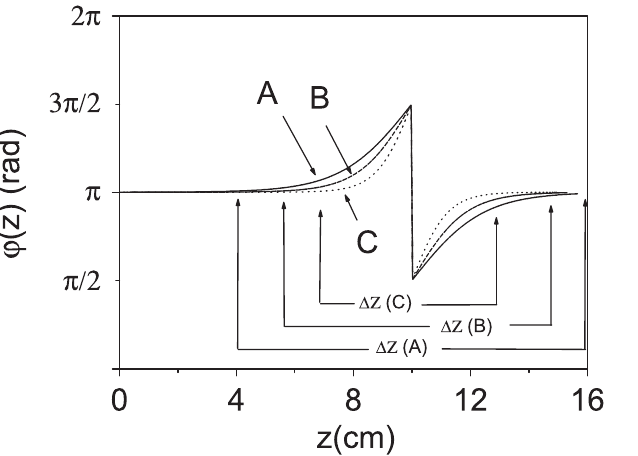
FIG. 11. Magnetic field profile for different lengths of the zone where the phase shift varies: (A) (cid:2) z ¼ 12 cm , (B) (cid:2) z ¼ 9 cm , (C) (cid:2) z ¼ 6 cm . FIG. 12. Longitudinal velocity evolution for different lengths of the zone where the phase shift varies: (A) (cid:2) z ¼ 12 cm , (B) (cid:2) z ¼ 9 cm , (C) (cid:2) z ¼ 6 cm